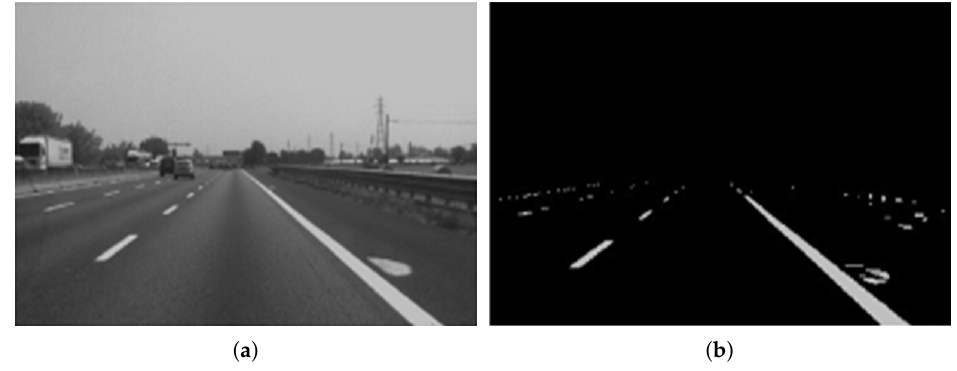
Figure 3. Dark-bright-dark filter result: ( a ) input image, and ( b ) dark-bright-dark filter result. It uses both edge and region detection results to more improve the accuracy of lane detection. To detect lanes, an edge detection algorithm calculates the median value between positive edge and negative edge from lane edges. In addition, edge detection calculates the median value from the region of interest (ROI) of a lane. It detects the lane if over- lapped median values are detected from both the edge and region detection results. It also detects